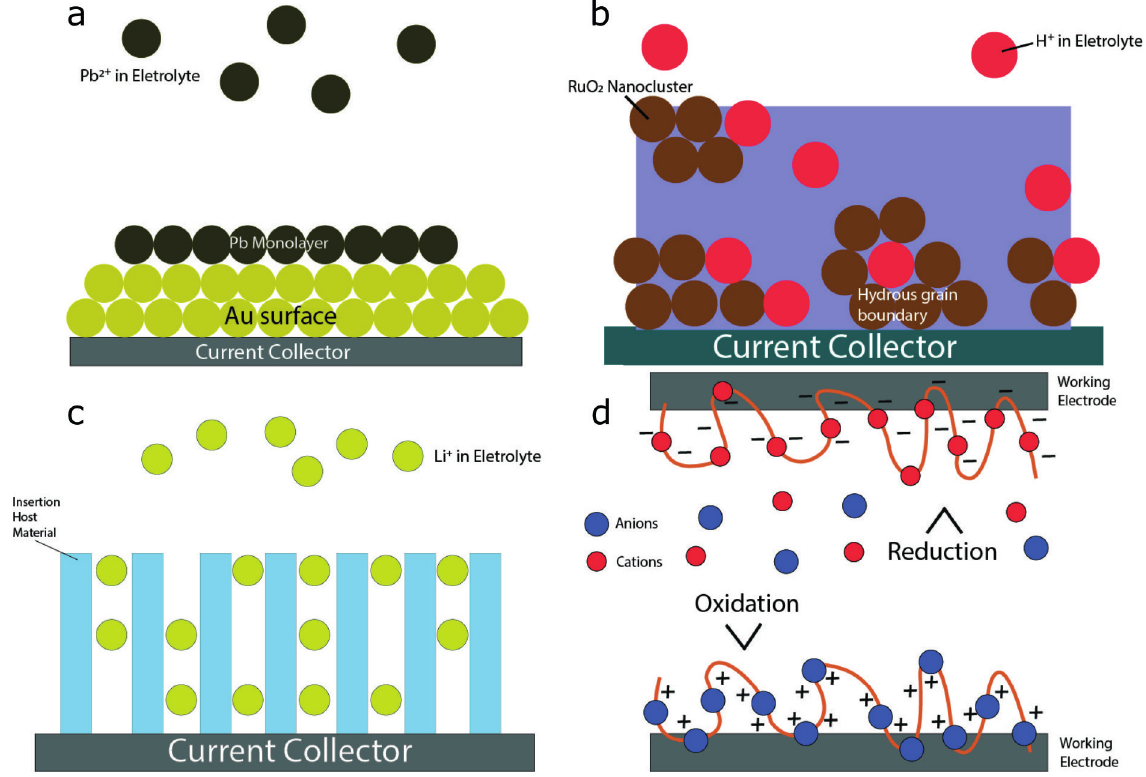
Figure 3. General scheme of pseudocapacitive process: a) underpotential deposition of Pb 2+ onto Au b) redox pseudocapacitance C) intercalation pseducapacitance of Li + into layered metal oxide d) charge compensation process (doping) of conducting